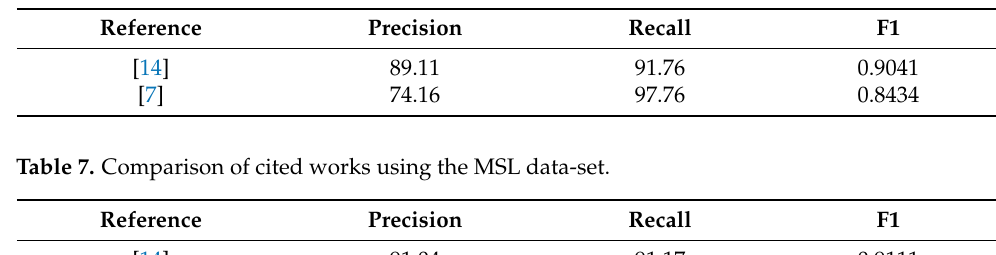
Table 6. Comparison of cited works using the SMAP data-set.